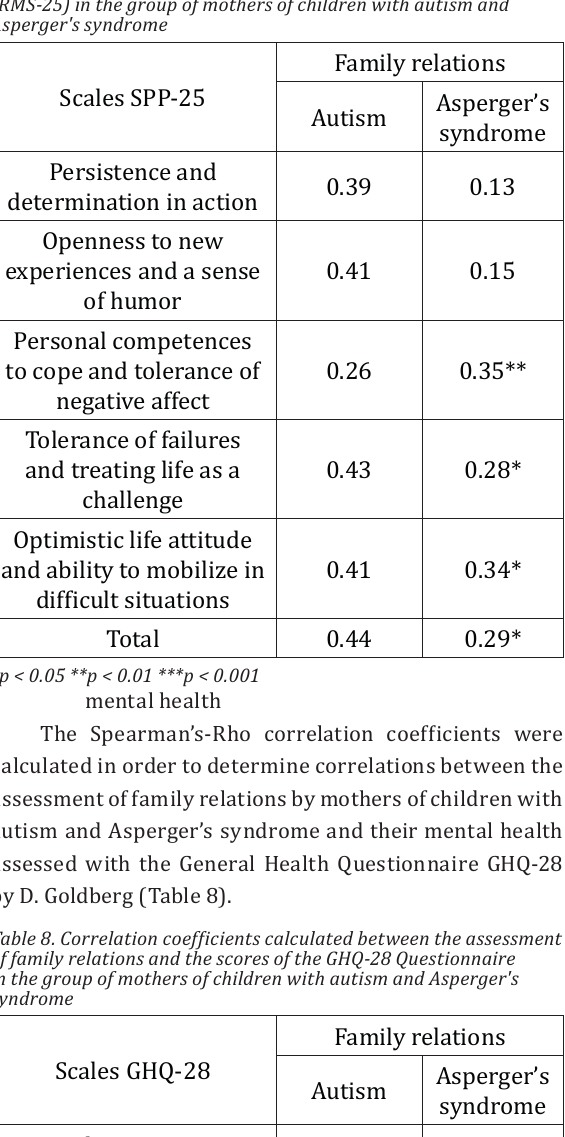
Table 7. Correlation coefficients calculated between the assessment of family relations and adaptation abilities measured with the